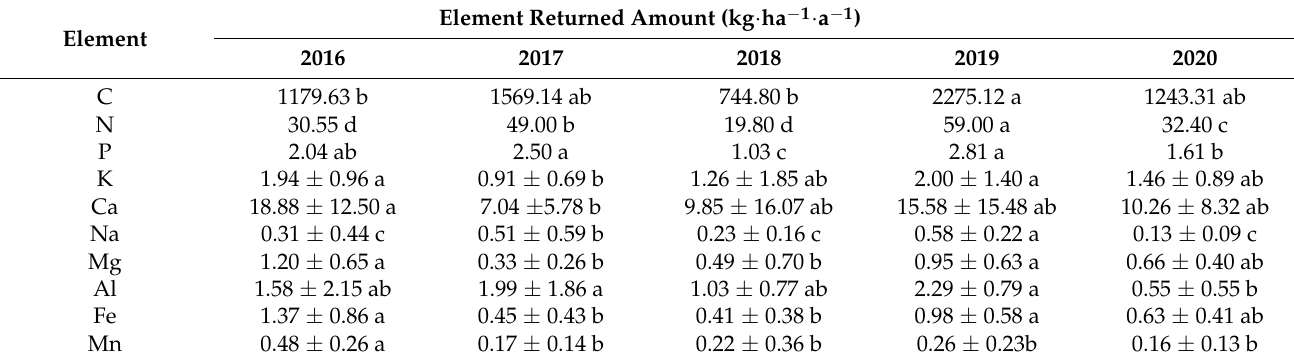
Table 2. The amount of each element returned by litterfall in the A. faxoniana forest from 2016 to 2020.